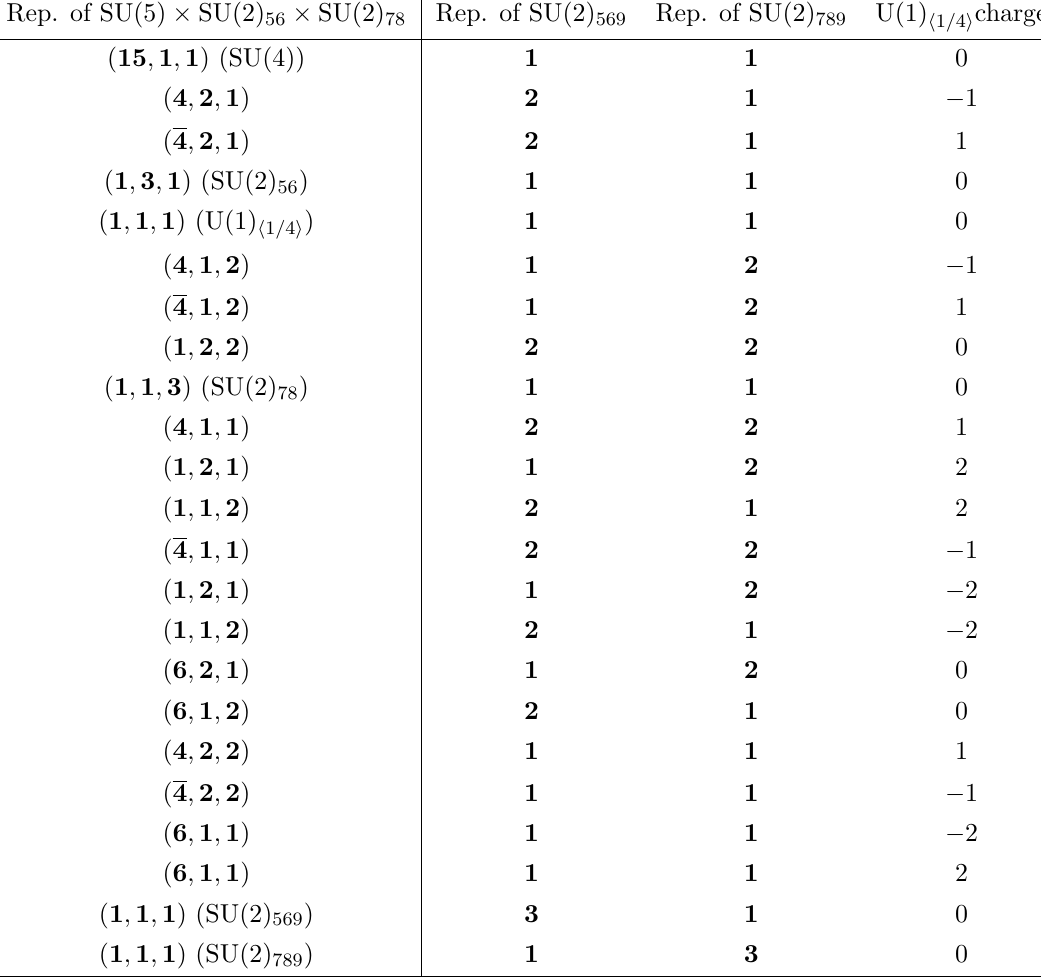
Table 19 . Decomposition of 248